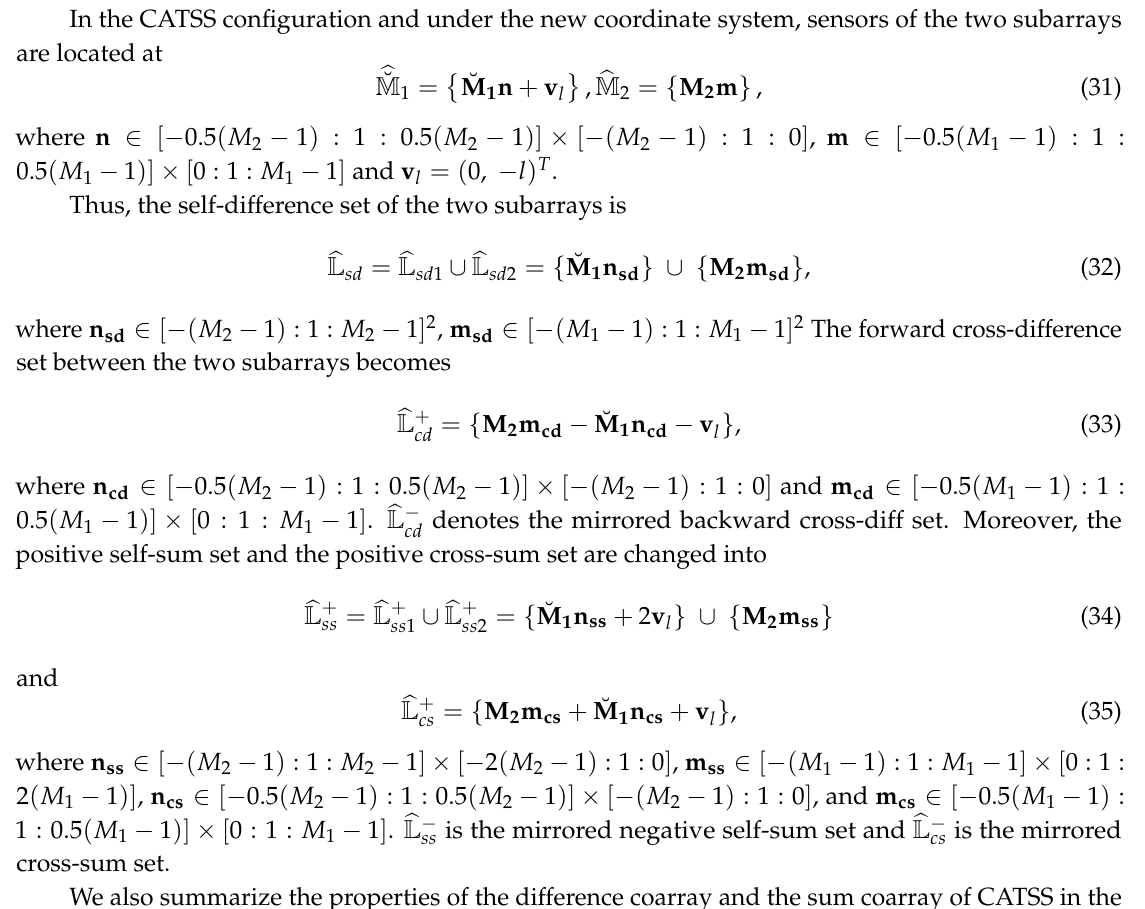
Figure 7. Cross coarrays of CATSS, where M 1 = 4, M 2 = 3, p = 2 and l = 7. ( a ) The cross-difference coarray. ( b ) The cross-sum coarray. ( c ) The cross-diff-sum coarray. Dashline boxes mark the overlapped area of the coarrays in each